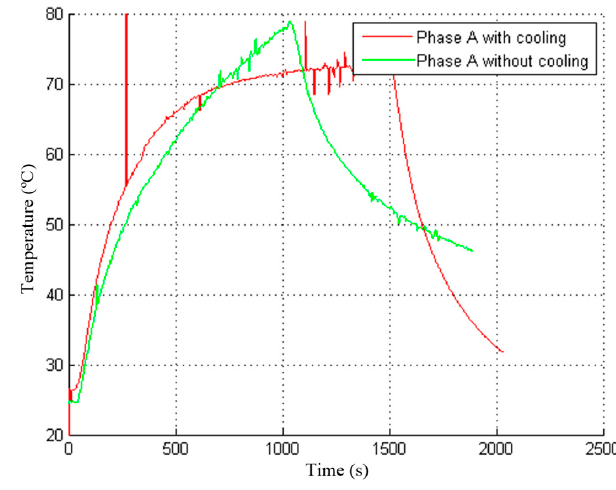
Figure 22. Experimental temperature with the nominal current.